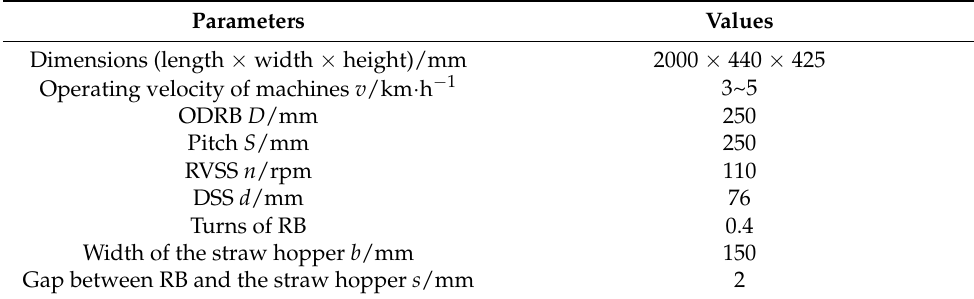
Table 5. Main technical parameters of